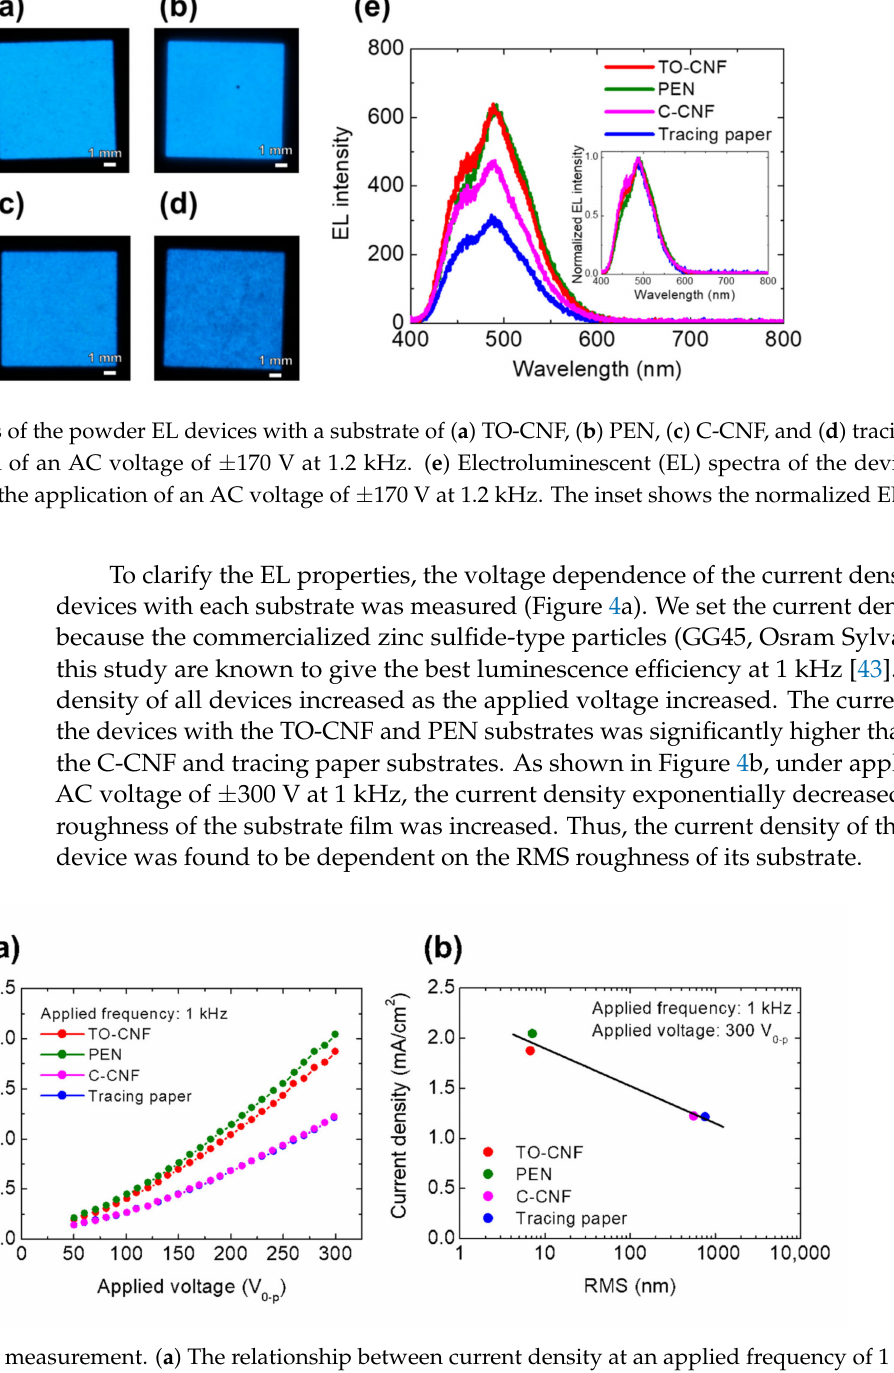
Figure 4. EL property measurement. ( a ) The relationship between current density at an applied frequency of 1 kHz and applied voltage. ( b ) The relationship between current density at an applied voltage of ± 300 V 0–p at 1 kHz and the RMS roughness of the substrate